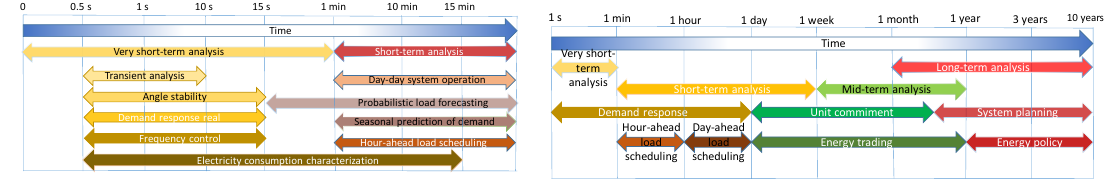
Figure 1. Temporal framework for analyzing the electrical energy system.